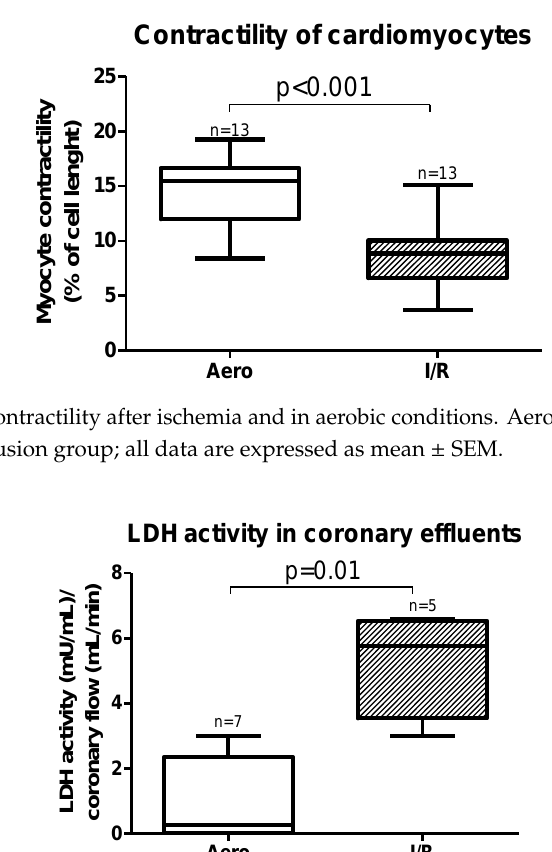
Figure 2. Lactate dehydrogenase (LDH) activity in coronary effluent after ischemia/reperfusion (I/R) and in aerobic conditions; all data are expressed as mean ± SEM.